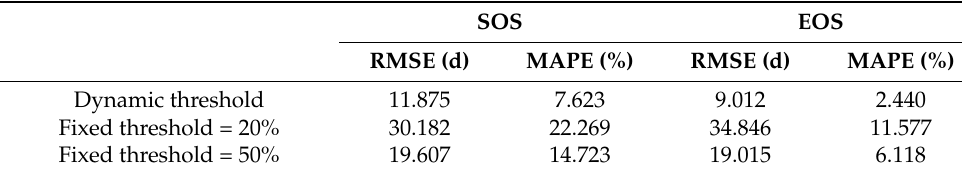
Table 4. The accuracy comparation of the extracted phenology.